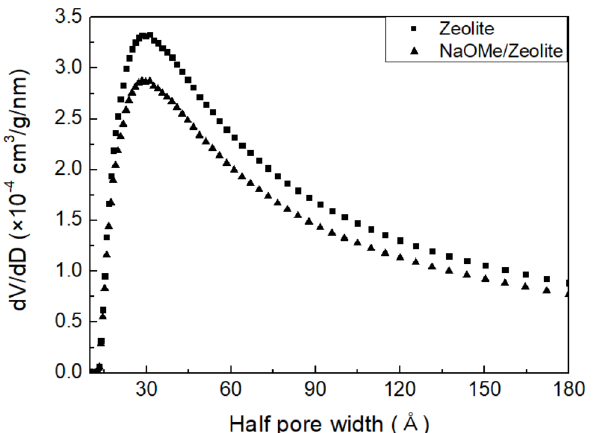
Figure 3. Graph of the BET surface area and cumulative pore volume to half − pore width. Table 1. BET surface area analysis of zeolite Y and NaOMe/zeolite catalysts. Characterization